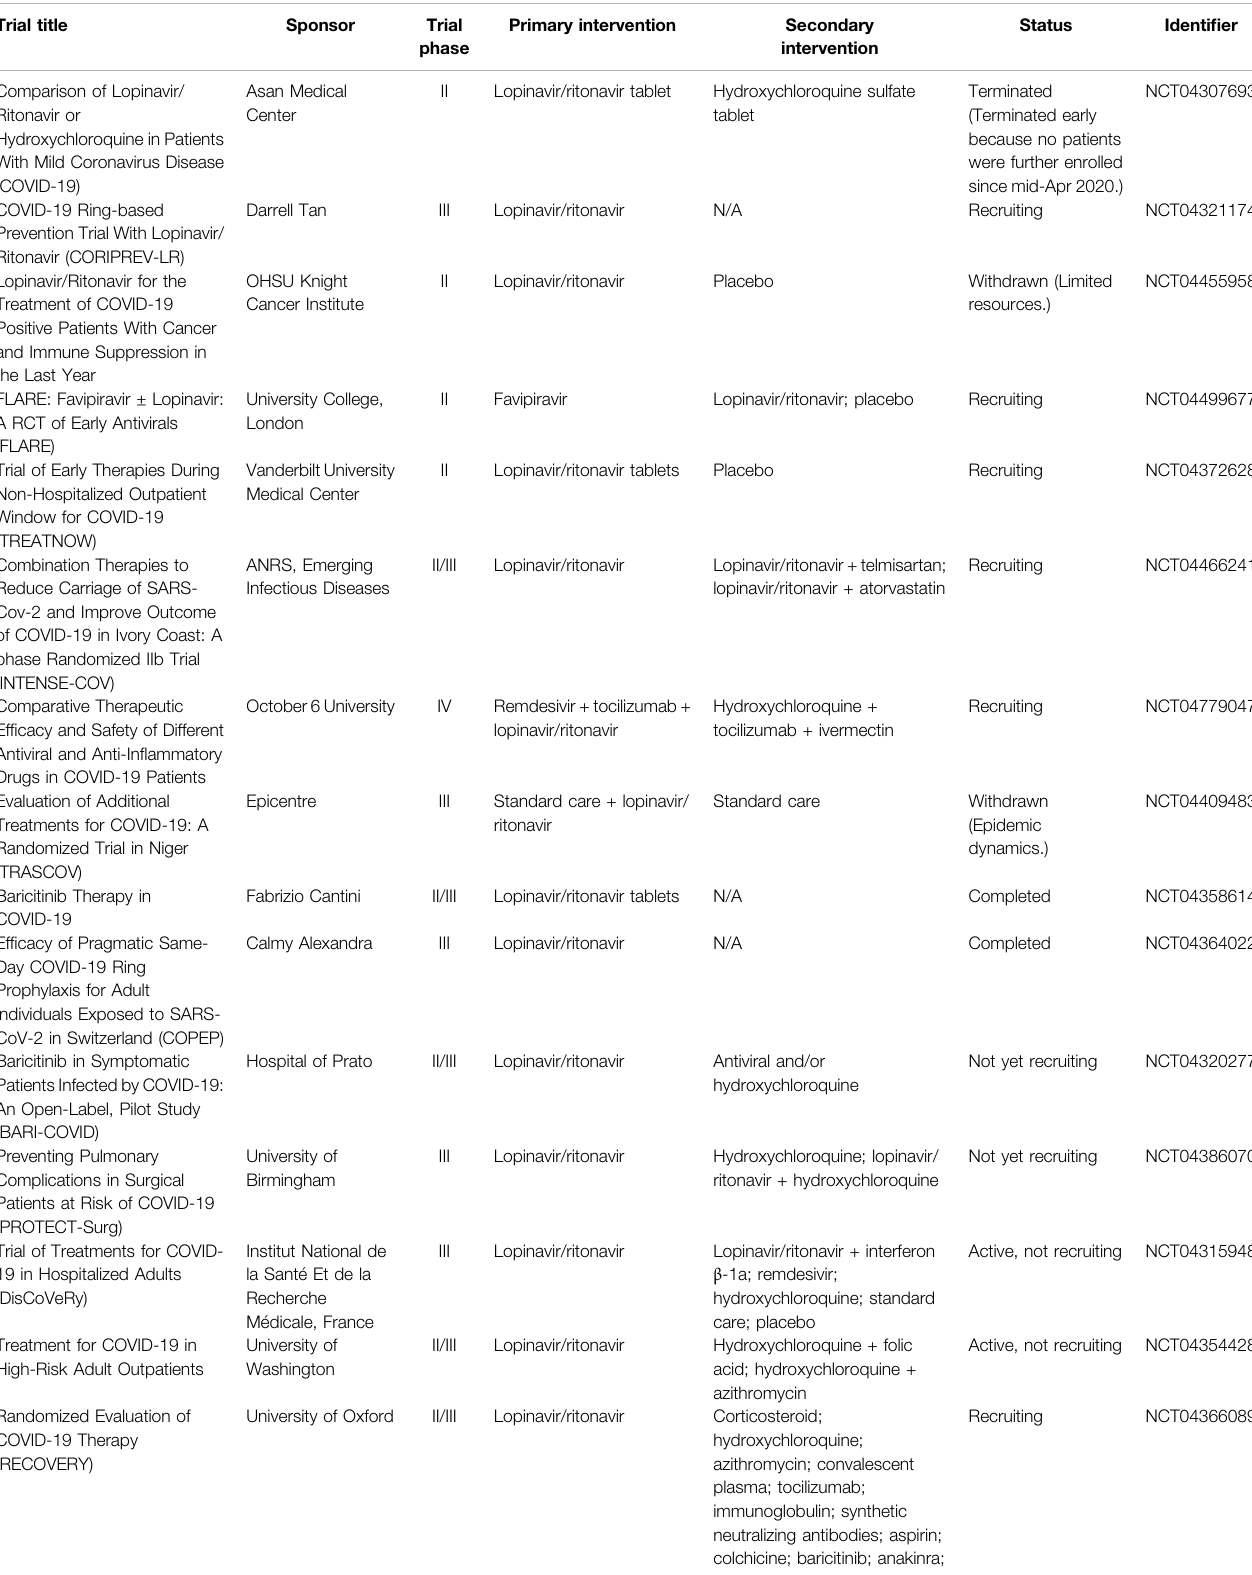
TABLE 2 | Summary of clinical trials of lopinavir/ritonavir on COVID-19